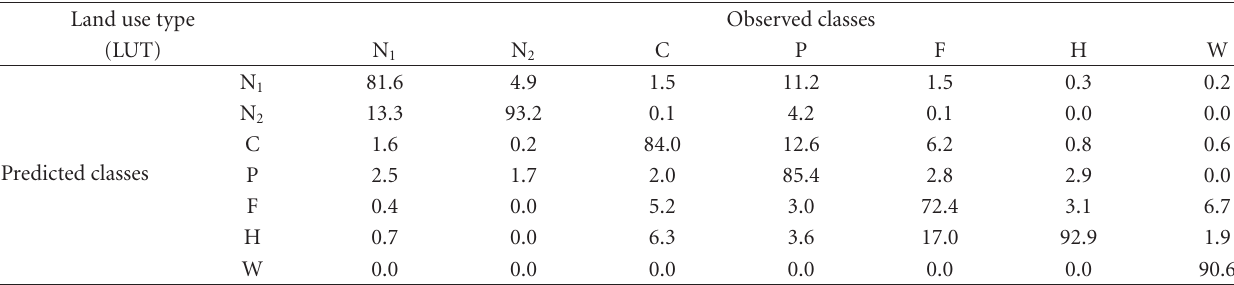
Figure 7: Soil drainage map derived from the discriminant analysis classification (DAC). Table 4: Classification accuracy (%) ∗ of land use types using supervised maximum likelihood classification applied on selected ASTER image attributes.